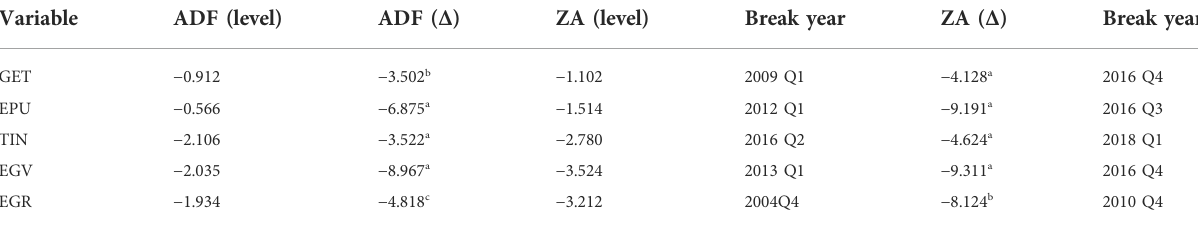
TABLE 3 Unit root test.